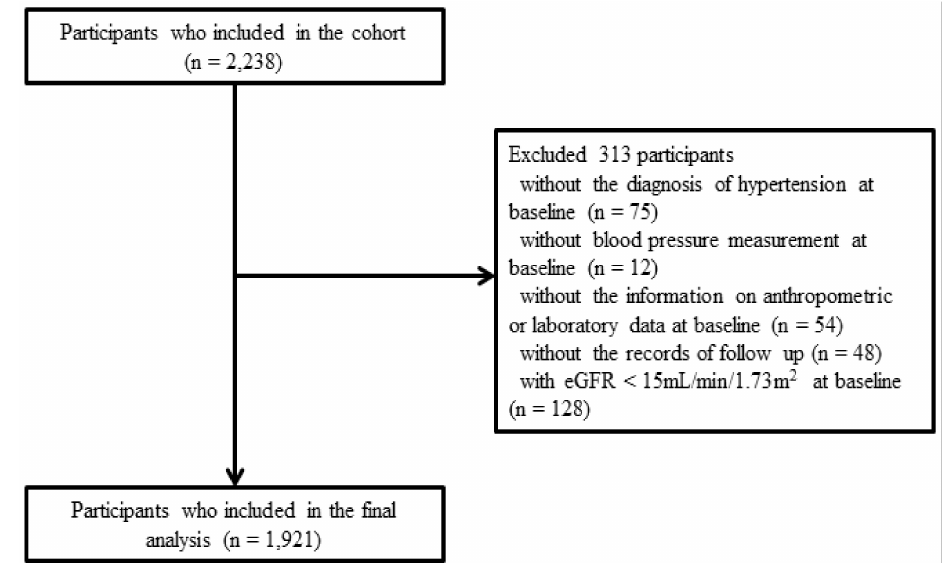
Figure 1. Flow diagram of the study population. Abbreviations: eGFR, estimated glomerular filtration